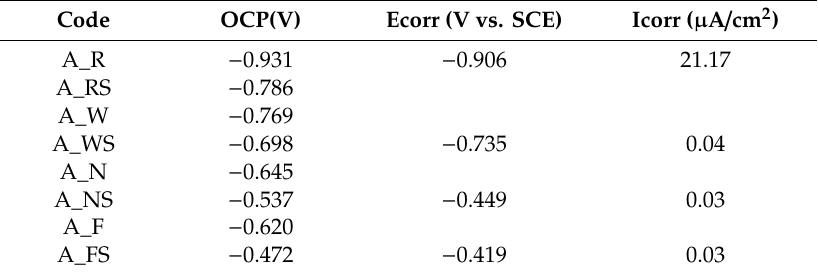
Table 4. Open circuit potential values (OCP) of AA6082 surfaces after di ff erent treatments steps in 3.5 wt.% NaCl